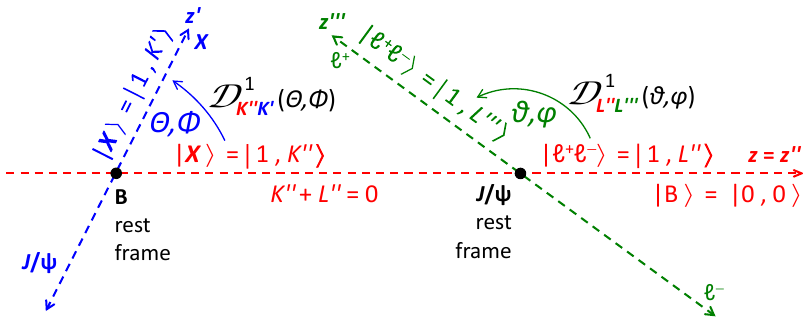
Figure 2 . Sketch of the cascade decay B → J /ψ X , J /ψ → ‘ + ‘ − , indicating the axes (CC frame), the decay angles, the angular momentum states of the involved particles, and the Wigner matrix elements used for their rotation. The red line represents the common direction of the B and J /ψ polarization axes ( z and z 00 , respectively) in the CC